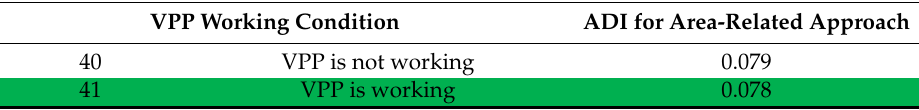
Table 11. Impact of flagging concept for area-related